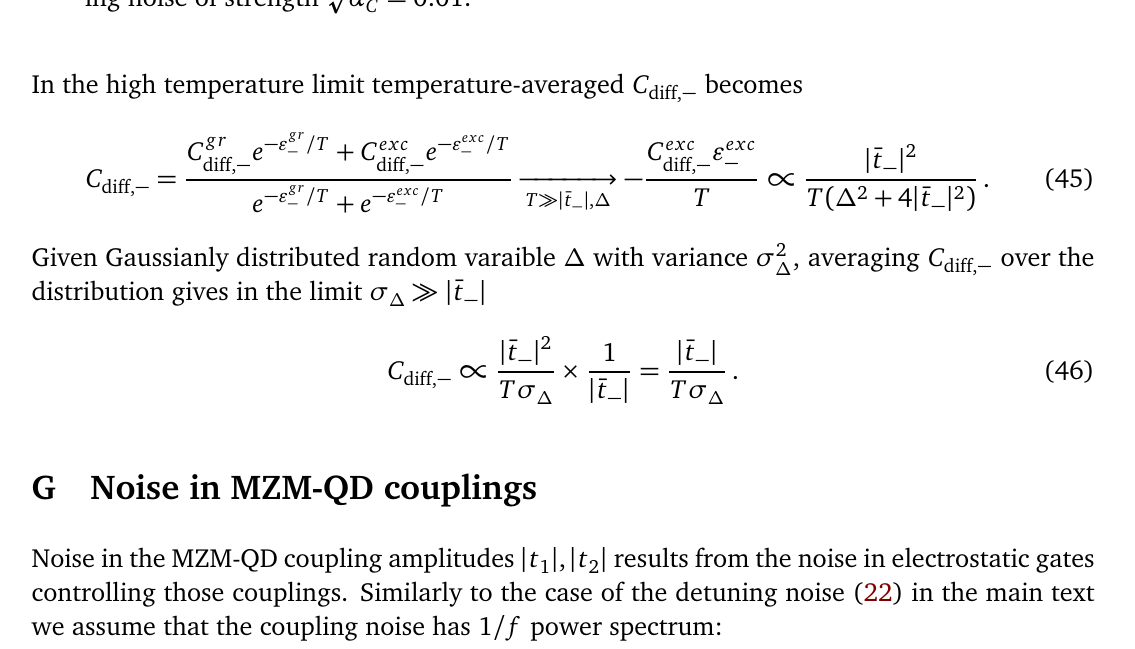
/ C Σ ,D (b) as a func- diff / C = 2 and the noise is detun- Σ ,D g